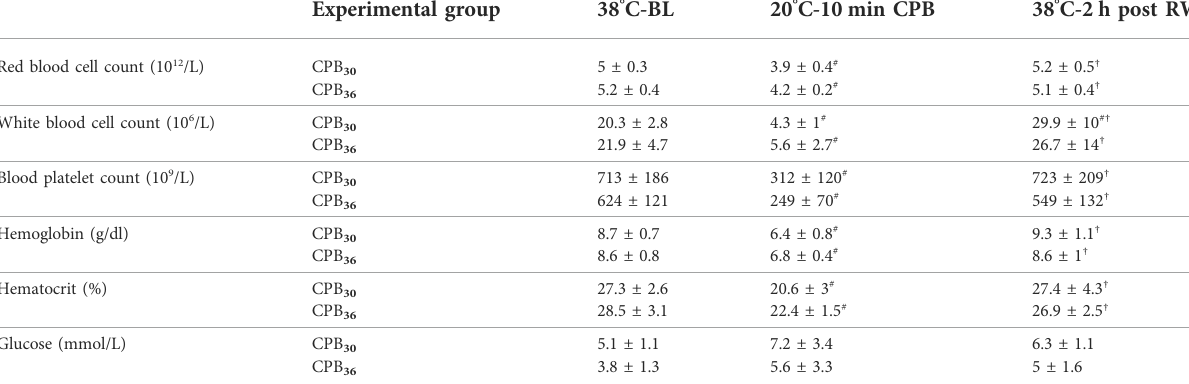
TABLE 2 Hematology and blood glucose.